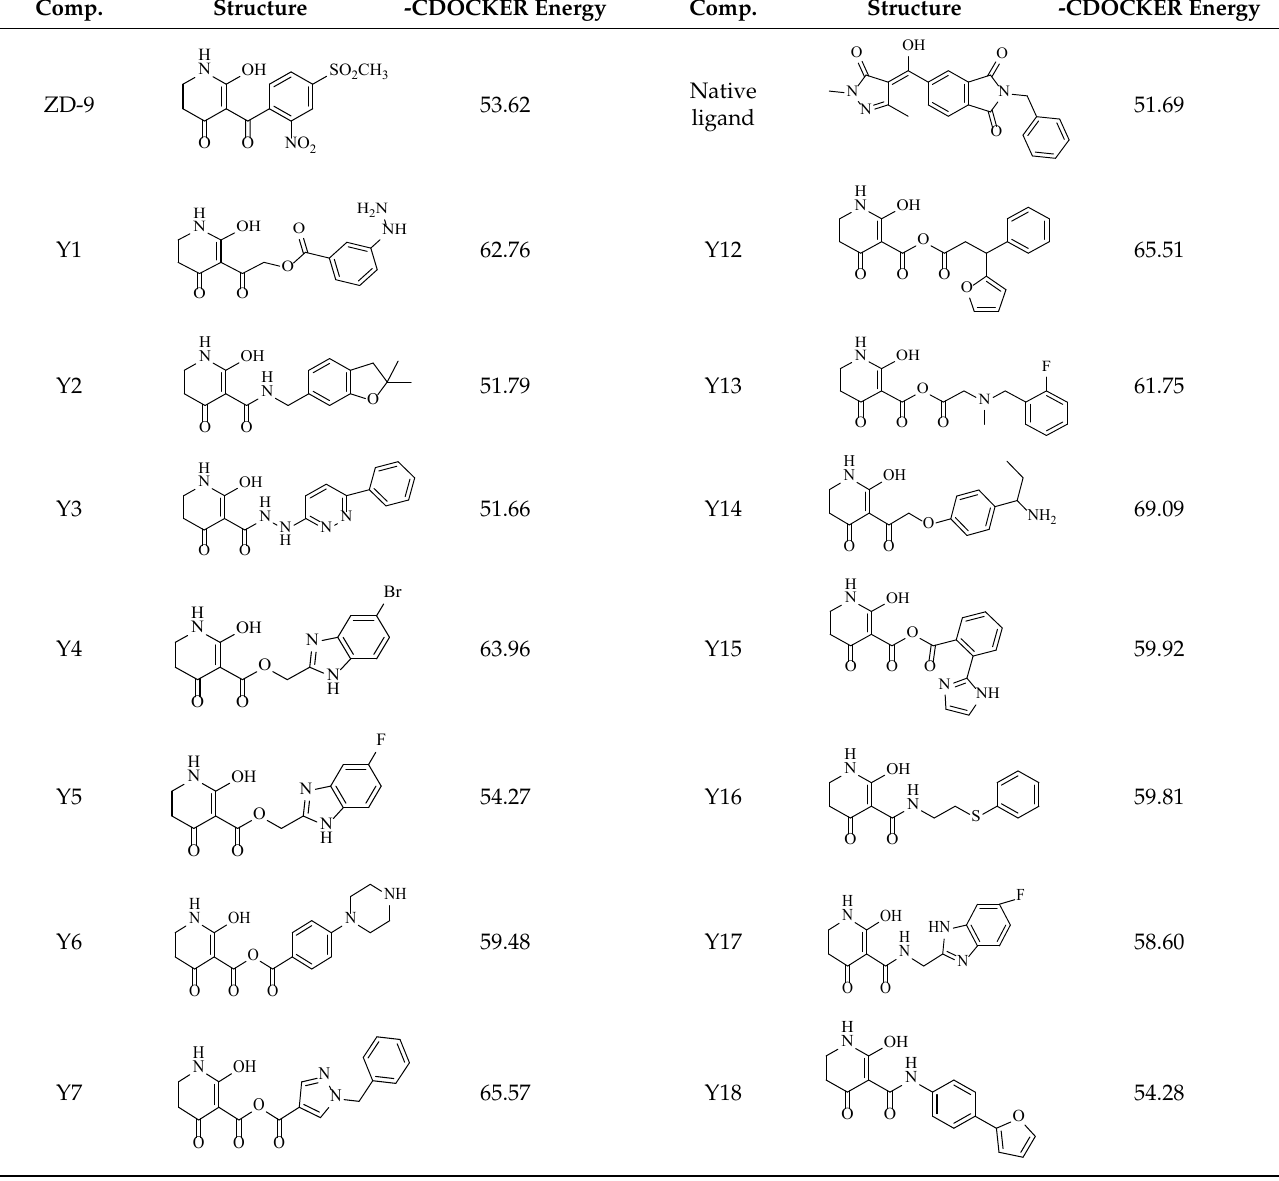
Table 2. Structures and -CDOCKER Energy (kcal/mol) of novel designed compounds.